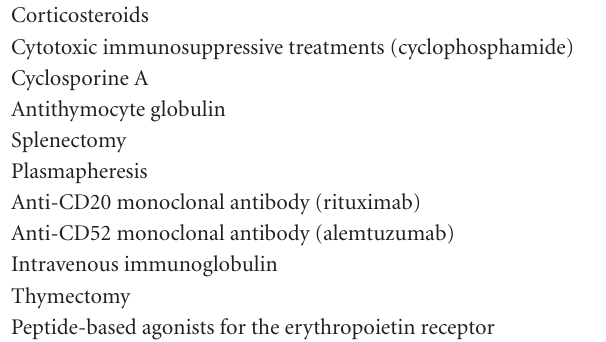
Table 4: Therapeutic strategies for PRCA [5].